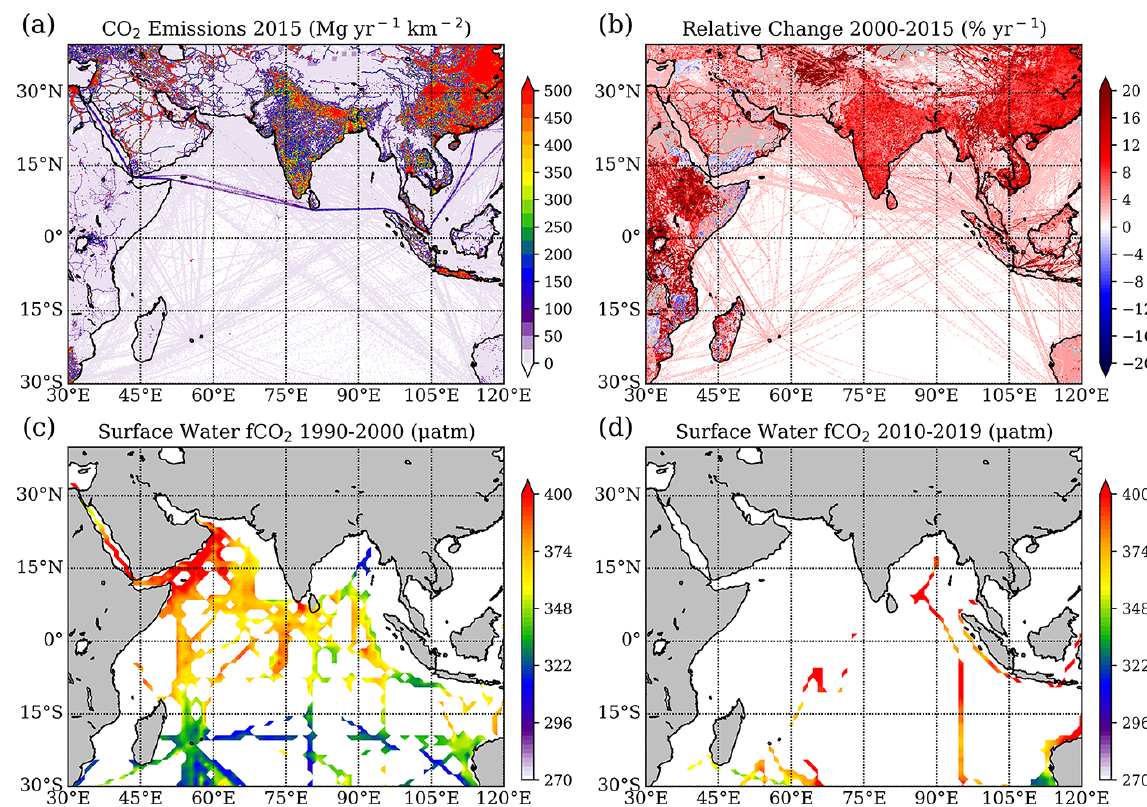
Figure 7. Annual mean CO 2 emissions for 2015 (a) and relative change with respect to 2000 (b) from EDGAR V5.0_GHG. Surface water f CO 2 observations (color shading, unit: µatm) over the Indian Ocean for 1990–2000 (c) and 2010–2019 (d) from SOCATv2019. Table 3. Emissions of CH 4 , N 2 O, and CO 2 from different regions in 2015 and their increase with respect to